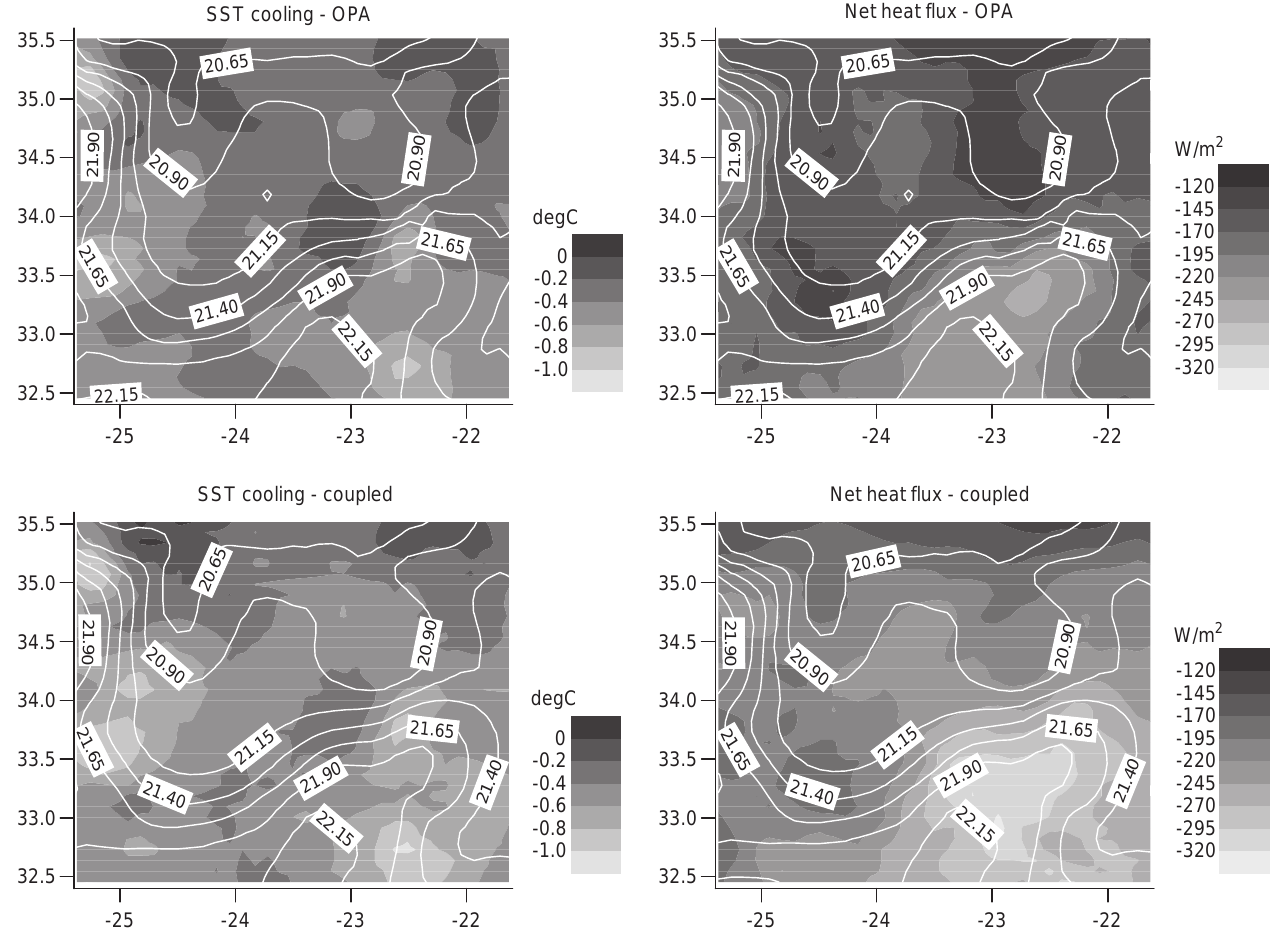
Fig. 8. Shading: SST cooling between 28 October and 1 November ( left ) and cumulated net heat flux over the same period ( right ). Isolines: Average SST field. Forced oceanic simulation ( top ) and coupled simulation ( bottom